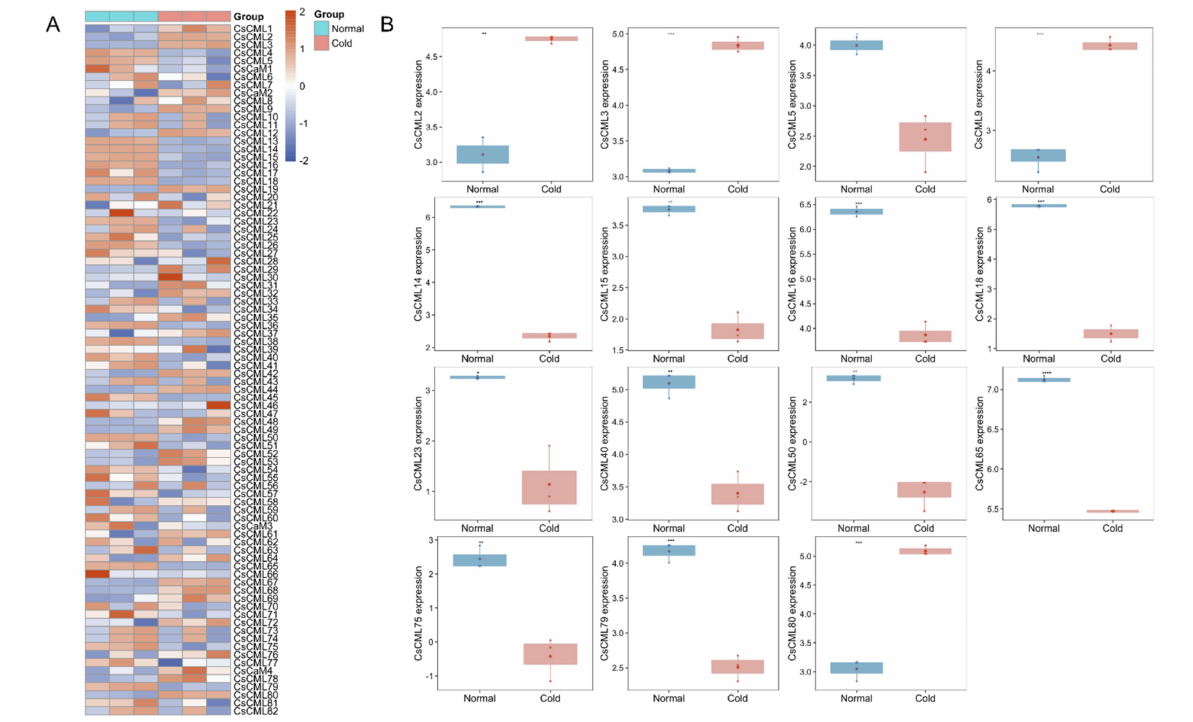
Figure 5. Expression of CsCaM/CML under low-temperature stress. ( A ) The heatmap showed the expression of CsCaM/CML gene family members in response to cold stress; gene expressions were scaled in the row. ( B ) Significantly differentially (*) expressed genes were depicted with boxplots using transcripts per million (TPM). Significance level symbols with one, two, three, and four asterisks represent p values less than 0.05, 0.01, 0.001 and 0.0001, respectively.